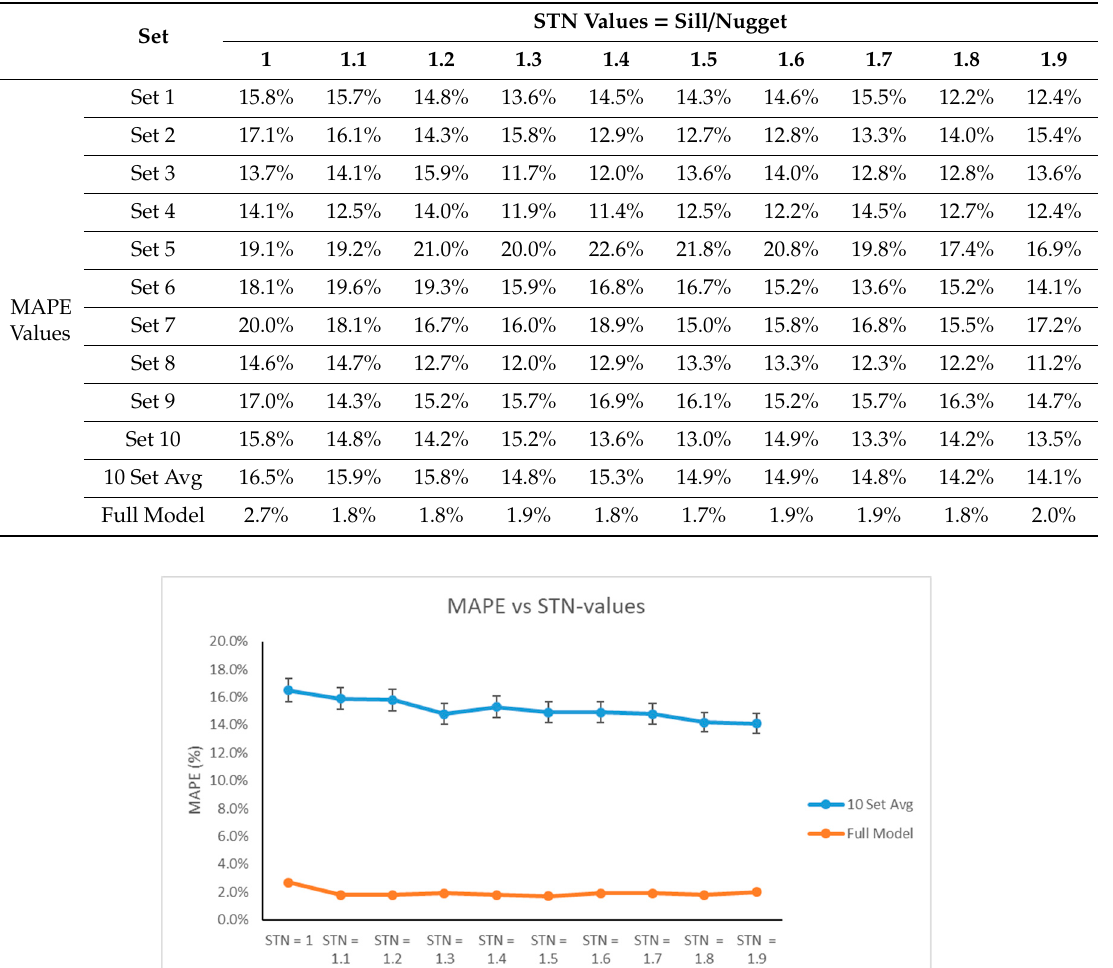
Table 5. Mean Absolute Prediction Error (MAPE) Values.